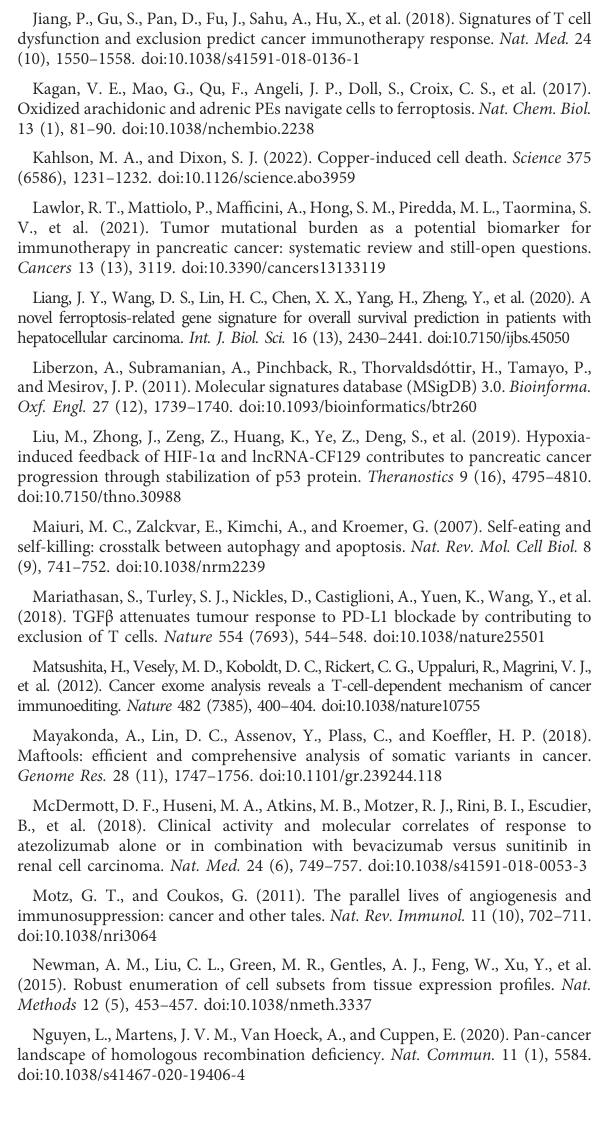
SUPPLEMENTARY FIGURE S1 External validation of the CuRS model. KM survival curves for patients in the (A) ICGC and (B) E-MTAB cohorts; Survival status of patients and expressionofmodelgenesinthe (C) ICGCand (D) E-MTAB cohorts; (E) 1-, 3-, 5-, and 8-year ROC curves for CuRS in the (E) ICGC and (F) E-MTAB cohorts. SUPPLEMENTARY FIGURE S2 Subgroup Cox analysis for the CuRS model. Subgroup Cox regression analysis of CuRS in (A) TCGA, (B) ICGC, and (C) E-MTAB cohorts. SUPPLEMENTARY FIGURE S3 ExternalvalidationofCuRSmodel-relatedtreatmentdecisions.Predicted IC 50 values for the four commonly used drugs in the high- and low- CuRS groups in the (A) ICGC and (B) E-MTAB cohorts; differences in immune responses predicted by the TIDE algorithm between the high- andlow-CuRSgroupsinthe (C) ICGCand (D)